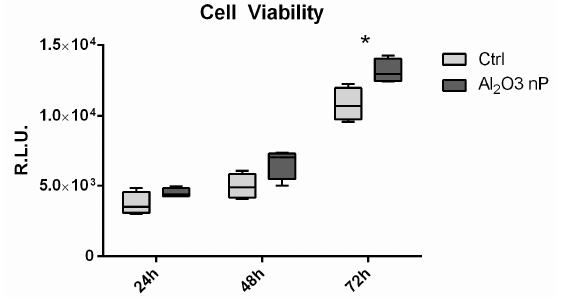
Figure 4. Cell viability evaluation. Cell viability of MC3T3-E1 performed through CellTiter-glo luminescent assay. Data are expressed as Relative Luminescent Unit (RLU) as measured at 24, 48, and 72 h after seeding. The symbol (*) indicates a statistically significant difference versus the control (Ctrl), considering a p -value < 0.05